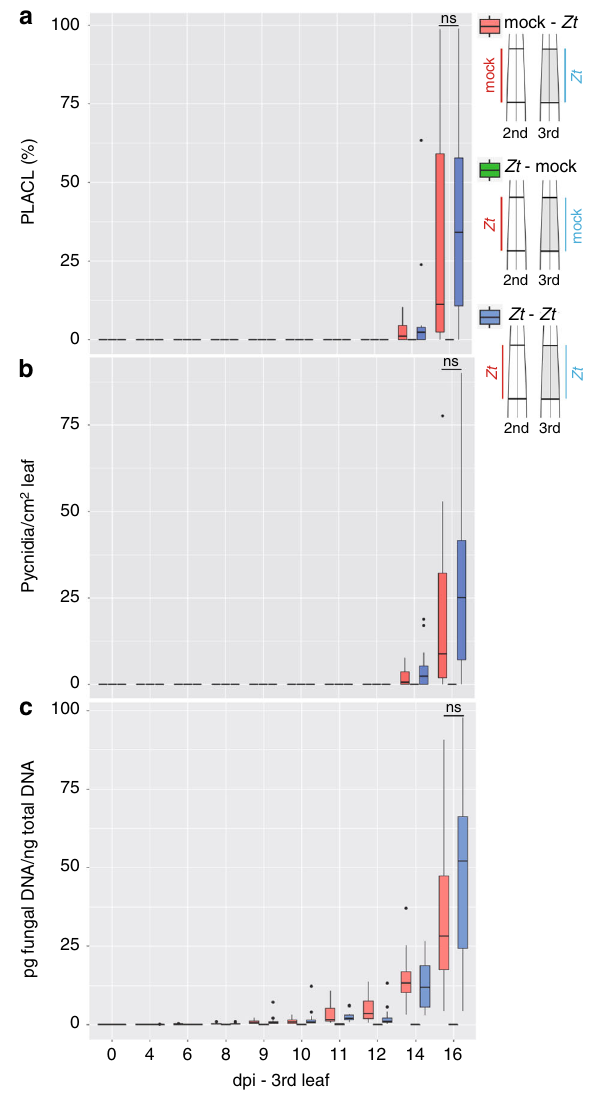
Fig. 6 Local infection with Z. tritici promotes systemic dissemination of the fungus. a Percentage of leaf area covered by lesions (PLACL) throughout infection of cultivar Obelisk with Z. tritici ( Zt ) IPO323. b Number of pycnidia of Zt per cm 2 leaf of cultivar Obelisk as in ( a ). c The picogram (pg) fungal DNA/nanogram (ng) total DNA measured by quantitative real- time PCR. Statistical analysis was performed using the Shapiro – Wilk test of normality followed by a Wilcoxon rank-sum test for null hypothesis. ns not signi fi cant. Number of biologically independent replicates: Zt -mock ( n = 3), mock- Zt and Zt – Zt : 0 – 6 dpi ( n = 12), 8 – 12 ( n = 12), 14 – 16 ( n =